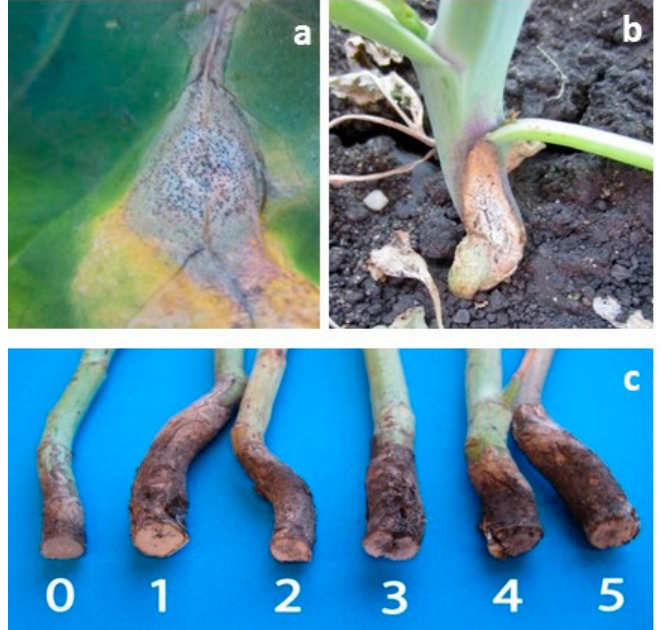
Figure 1. Blackleg lesion on a canola leaf showing pycnidia ( a ); blackleg canker on the lower stem of a mature plant ( b ); rating scale used to assess blackleg disease severity on canola, showing stem cross-sections ( c ).